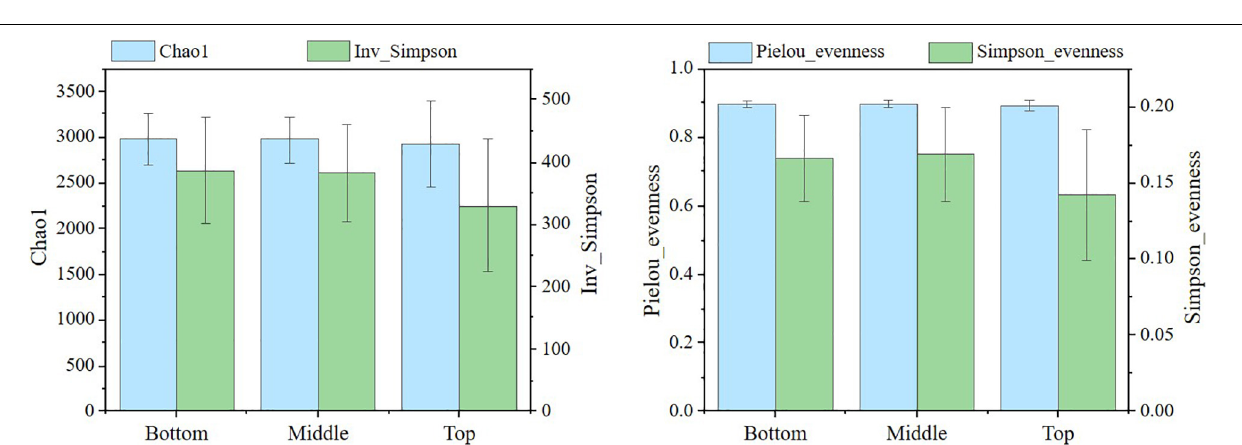
FIGURE 3 | Soil microbial community diversity at different locations in the subsidence